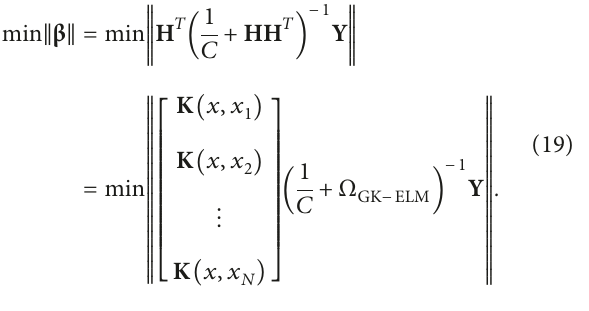
Figure 10. As the barycenter will deviate horizontally while sitting on a chair, there is some error in F2 of sitting on a chair.